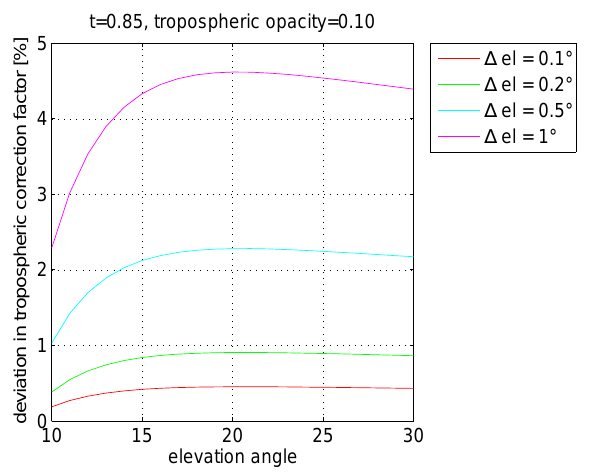
Fig. 9. Calibration of the elevation pointing of MIAWARA-C us- ing the sky scanning method. Upper panel: Calibrated sky scans. Lower panel: First derivative of sky brightness temperature and polynomial fit of third